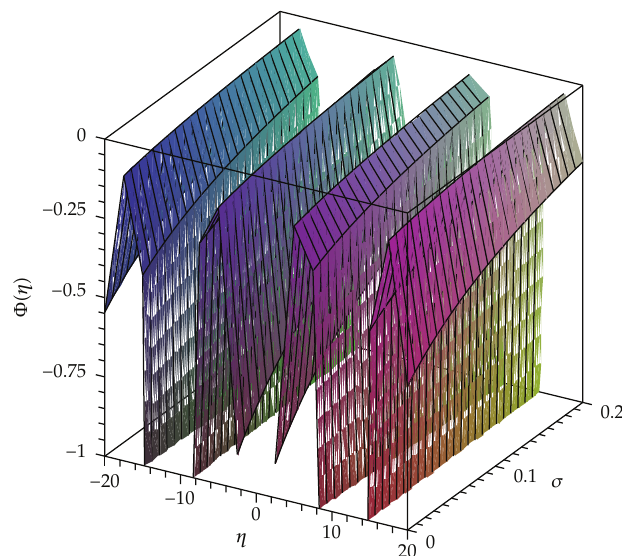
Figure 5: Weierstrass elliptic doubly periodic type solution (cid:2) 4.13 (cid:3) for v (cid:7) 0 . 04, γ 0 (cid:7) 0 . 01, c 0 (cid:7) − 1, c 1 (cid:7) 1, and c 3 (cid:7) 0 .